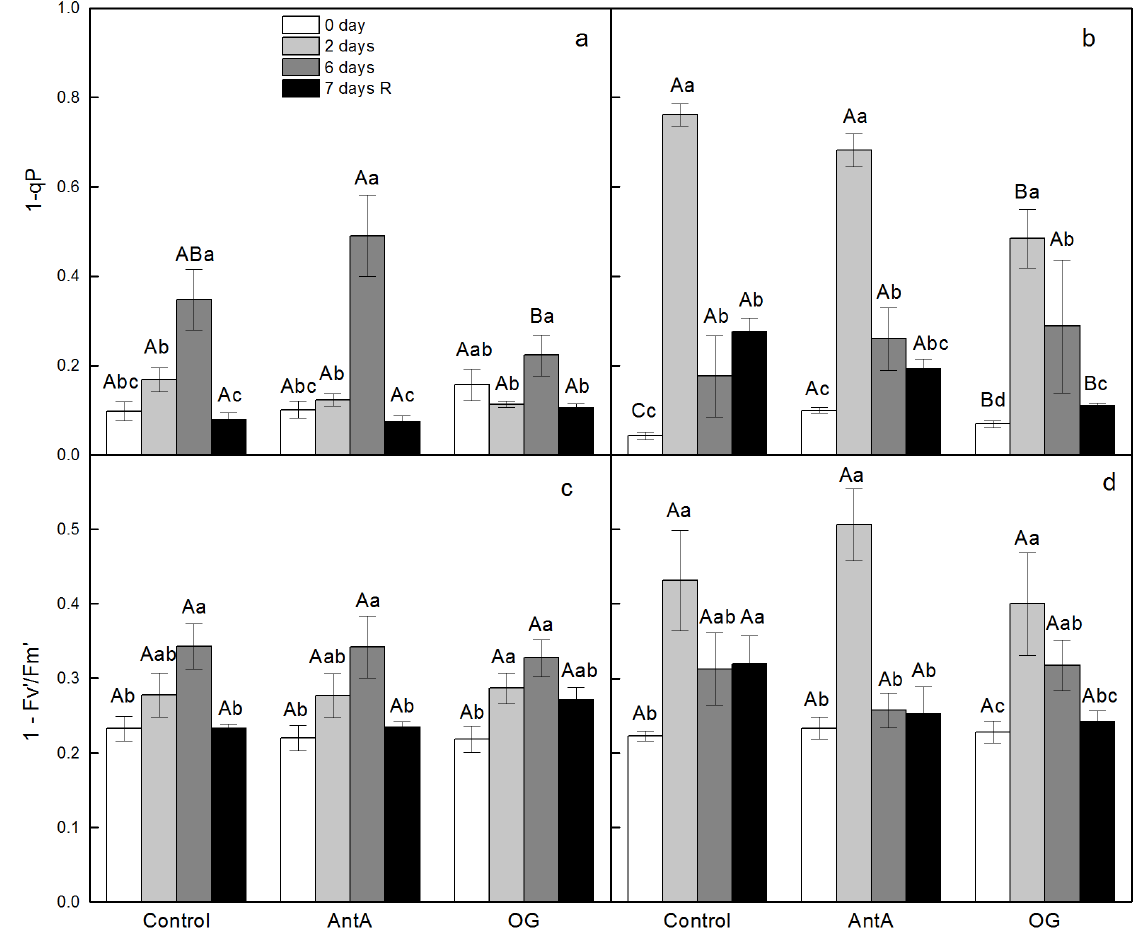
Figure 2. Effect of specific electron transport inhibitors, antimycin A (AntA) for protein gradient regulator 5 (PGR5) and octyl gallate (OG) for plastid terminal oxidase (PTOX), on the excitation pressure of PSII (1-q P , q P —coefficient of photochemical quenching) ( a , b ) and on the proportion of light energy absorbed and dissipated in the antenna of PSII (1-F v (cid:48) /F m (cid:48) , where F v (cid:48) is the variable fluorescence in light acclimated state equal to F m (cid:48) -F o (cid:48) , where F o (cid:48) and F m (cid:48) are the minimal and maximal chlorophyll fluorescence levels in light acclimated state, respectively) ( c , d ) in leaf discs of Arabidopsis thaliana , wt ( a , c ) and lut2 ( b , d ), that were floated for 2 h either on distilled water (Control) or in the presence of inhibitors. Leaf discs were taken either from plants before the start of every experiment (0 day), after 2 or 6 days of treatment with two stress stimuli or after the recovery period (7 days R). The concentration of inhibitors in distilled water was—10 µ M AntA or 20 µ M OG. Mean values ± standard error (SE) were calculated from three parallel samples of two independent experiments ( n = 6). Different letters indicate significant differences for the respective parameters at p < 0.05 (upper- case for the different treatments (Control, AntA and OG) on a certain day; lowercase for the certain treatment at a different time periods (0 day, 2 days, 6 days and 7 days R)).